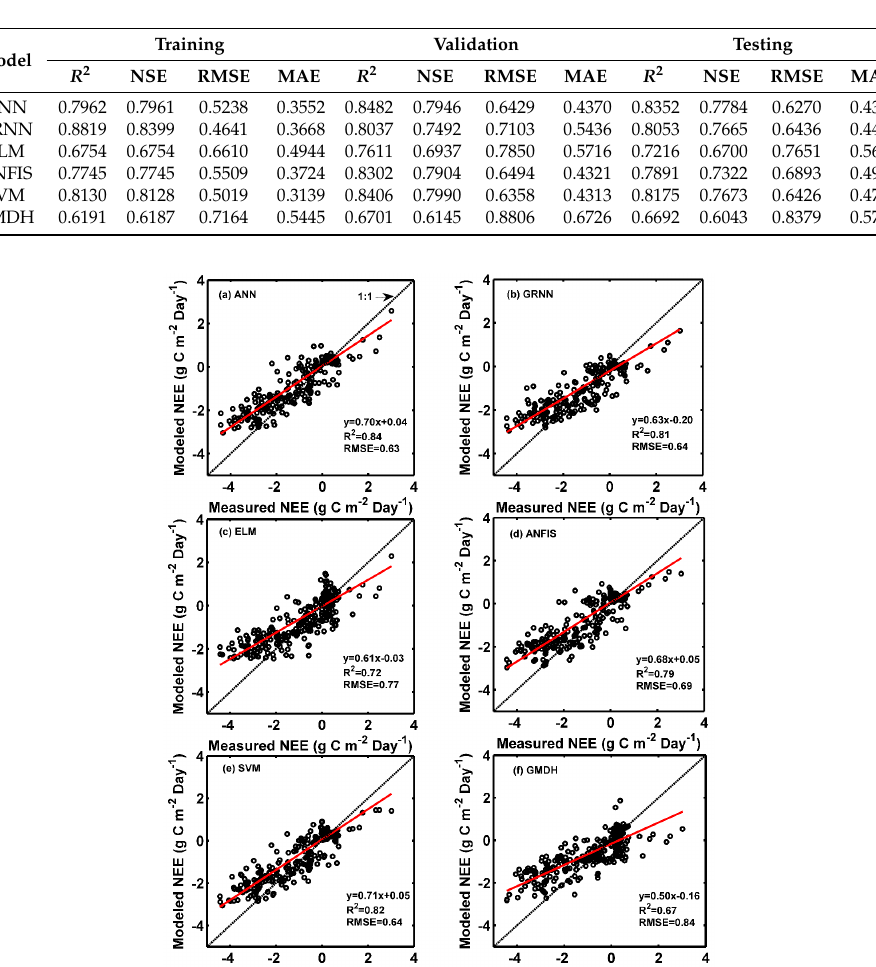
Figure 6. Comparisons of daily NEE measured by eddy covariance technique and predicted by data-driven models for the testing period. ( a ) ANN model; ( b ) GRNN model; ( c ) ELM model; ( d ) ANFIS model; ( e ) SVM model; and ( f ) GMDH model.